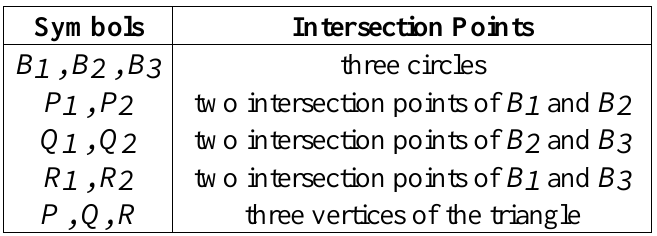
Table 1. Symbols for intersection points.